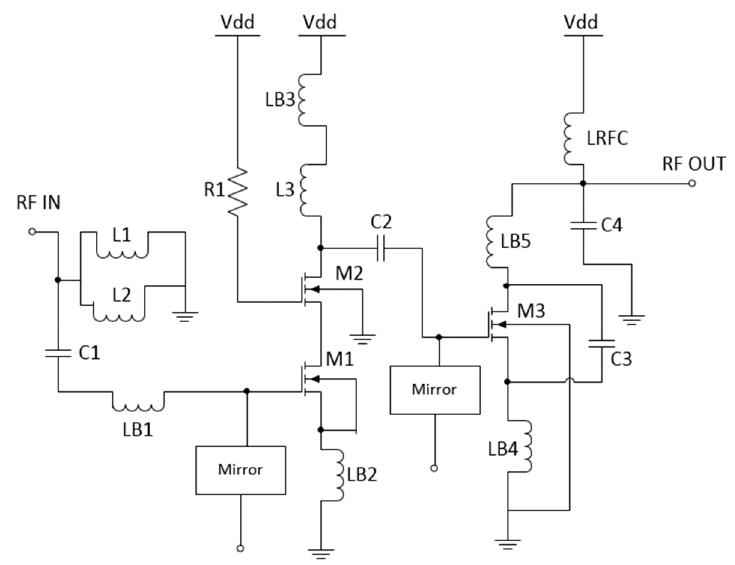
Figure 4. Schematic of a two-stage class-E PA [34].